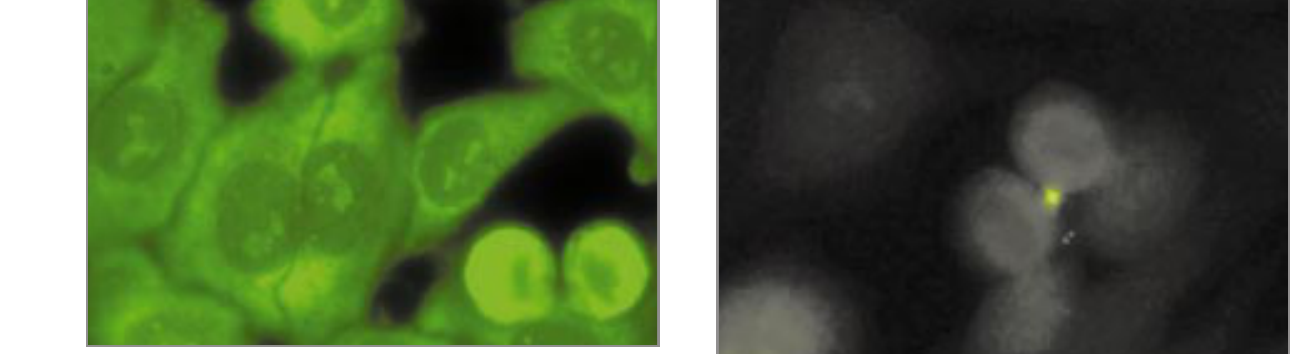
Figura 18 – Citoplasmático pontilhado fino denso